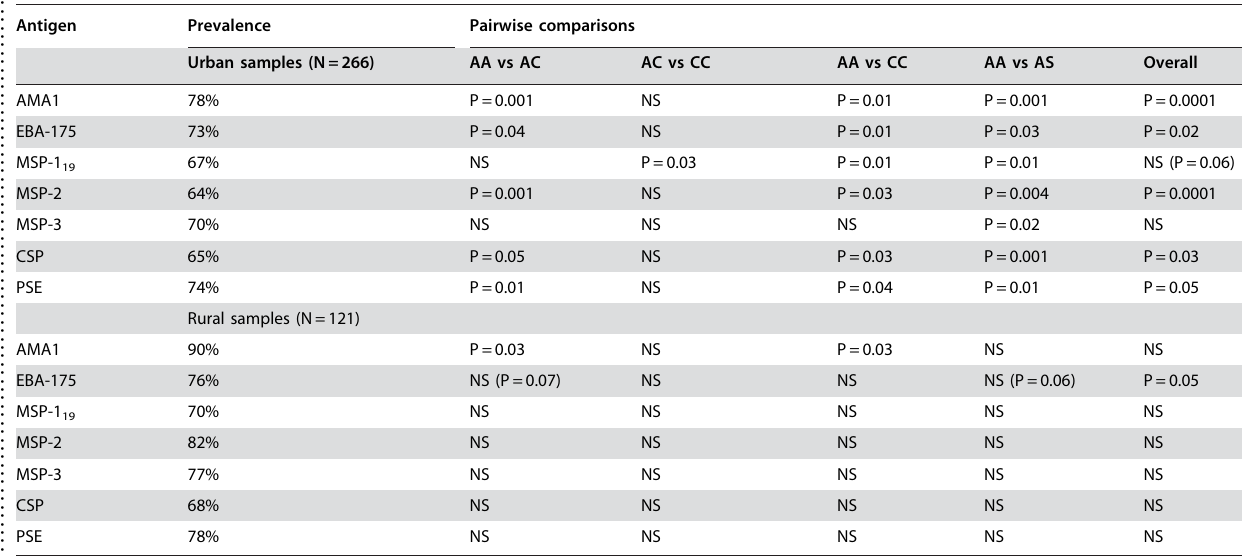
Table 2. Total IgG means of log transformed OD values against several blood stage antigens (AMA1, EBA-175, MSP-1 19 , MSP-2,